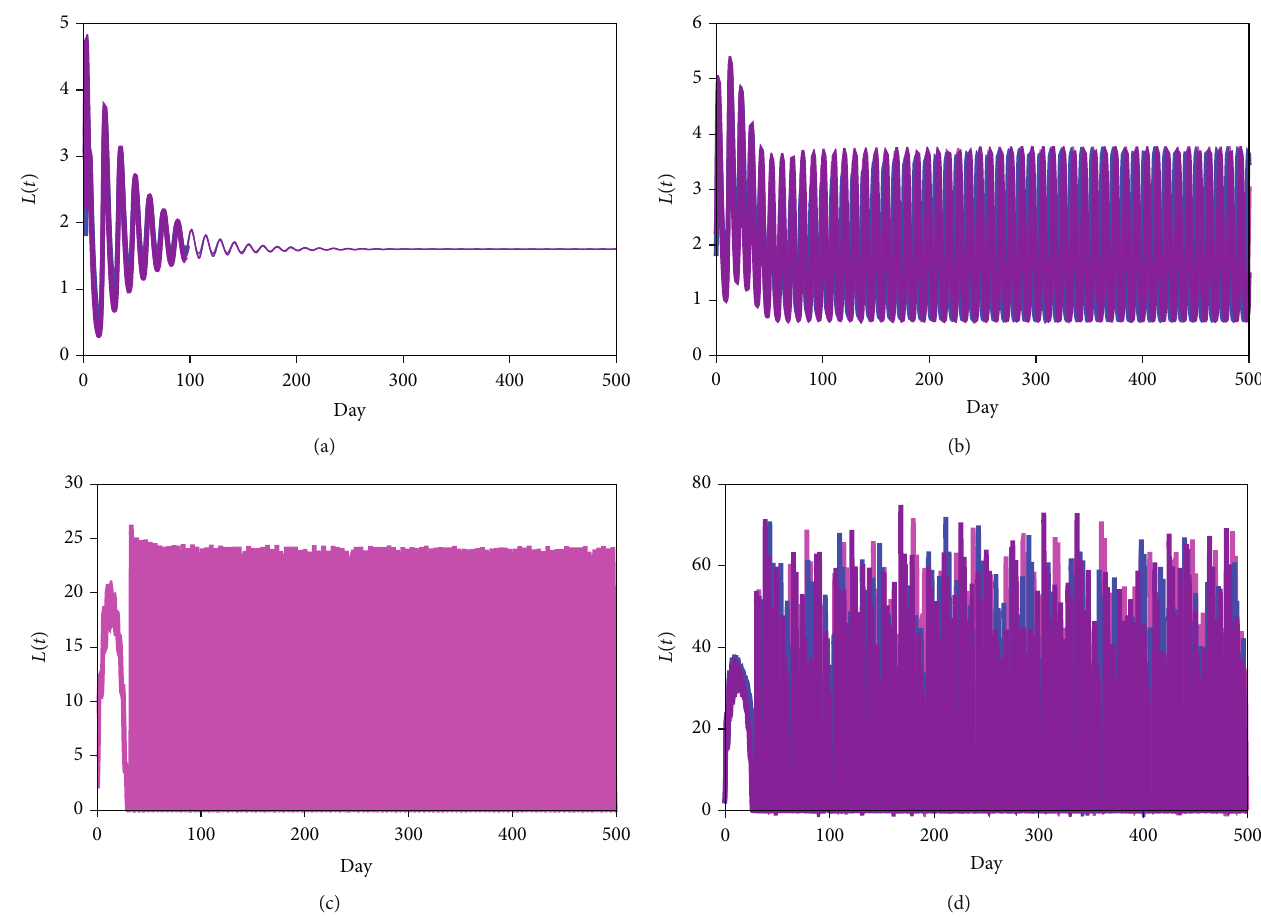
= 0 : 005 ; (b) γ = 0 : 0095 ; (c) γ = 0 : 075 ; and (d) γ = 0 : 16 for model (1) with 2 2 2 2